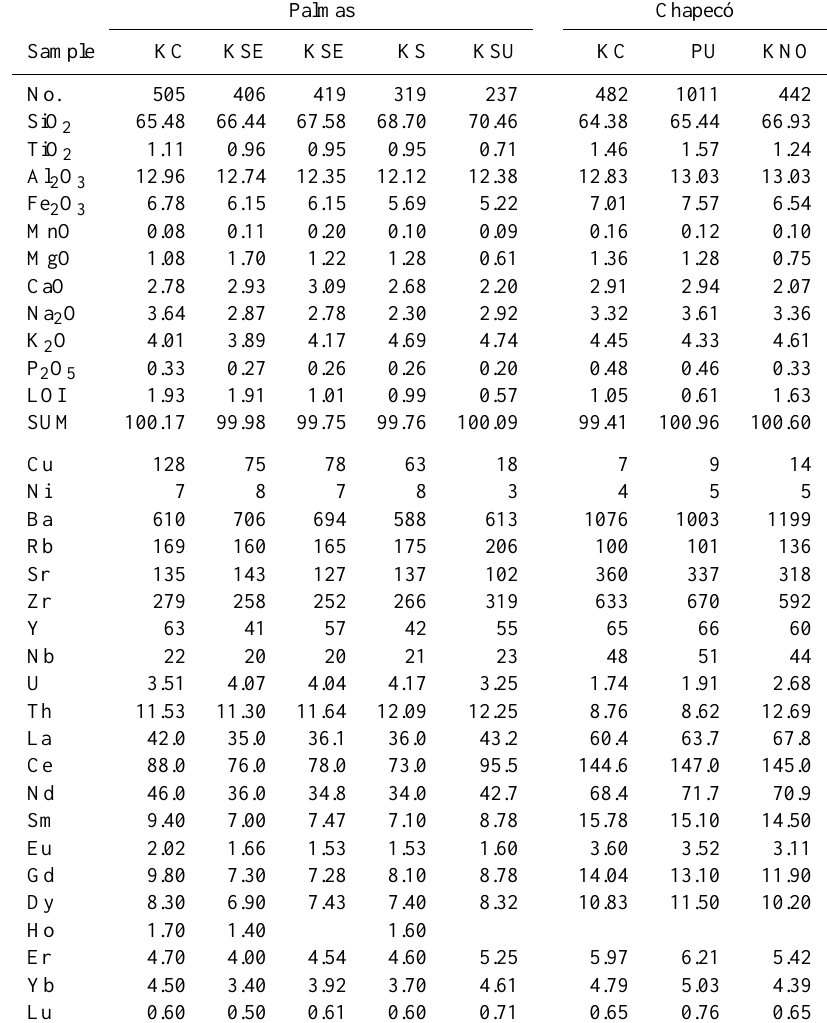
Table 1. Representative analysis of Palmas and Chapecó silicic volcanics of the PMP (major elements, in oxide wt%; trace elements, in